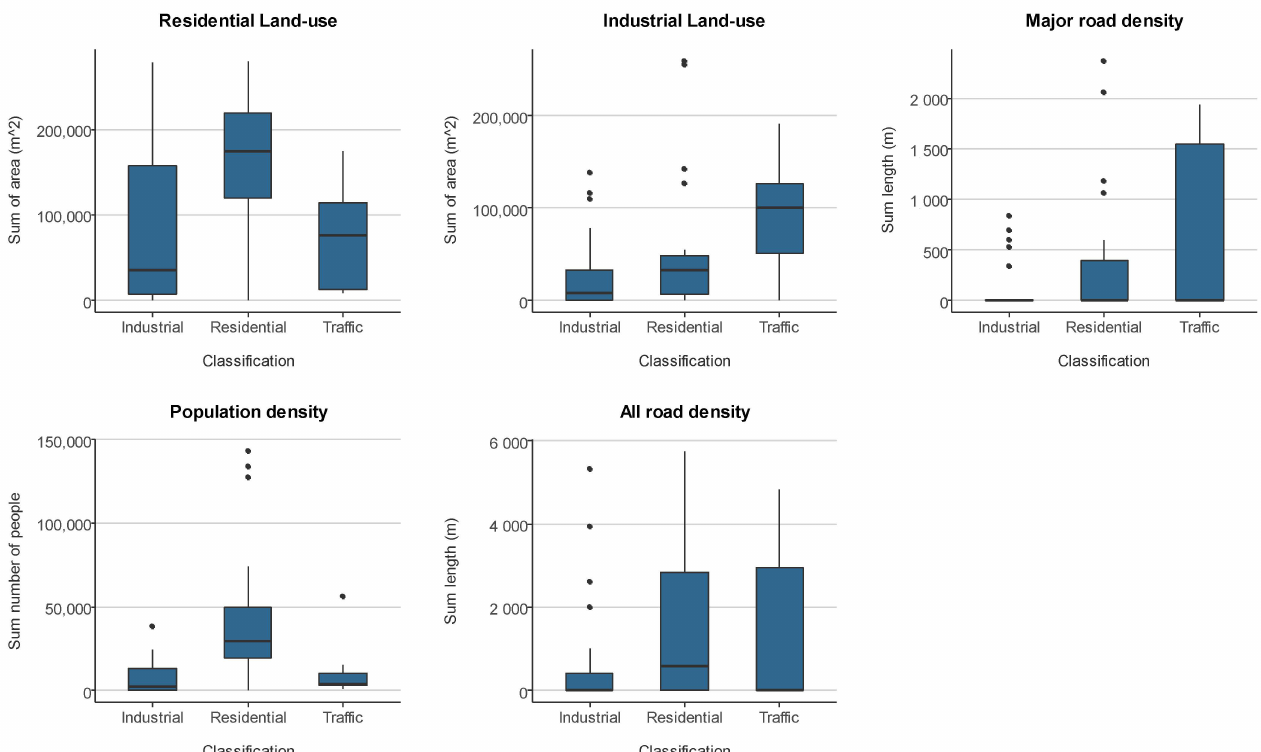
Figure 2. Distribution of indicators of PM 10 emissions; land use (sum of area, m 2 ), road density (sum length, m) and population (sum number of people) within a 300 m buffer across the three site